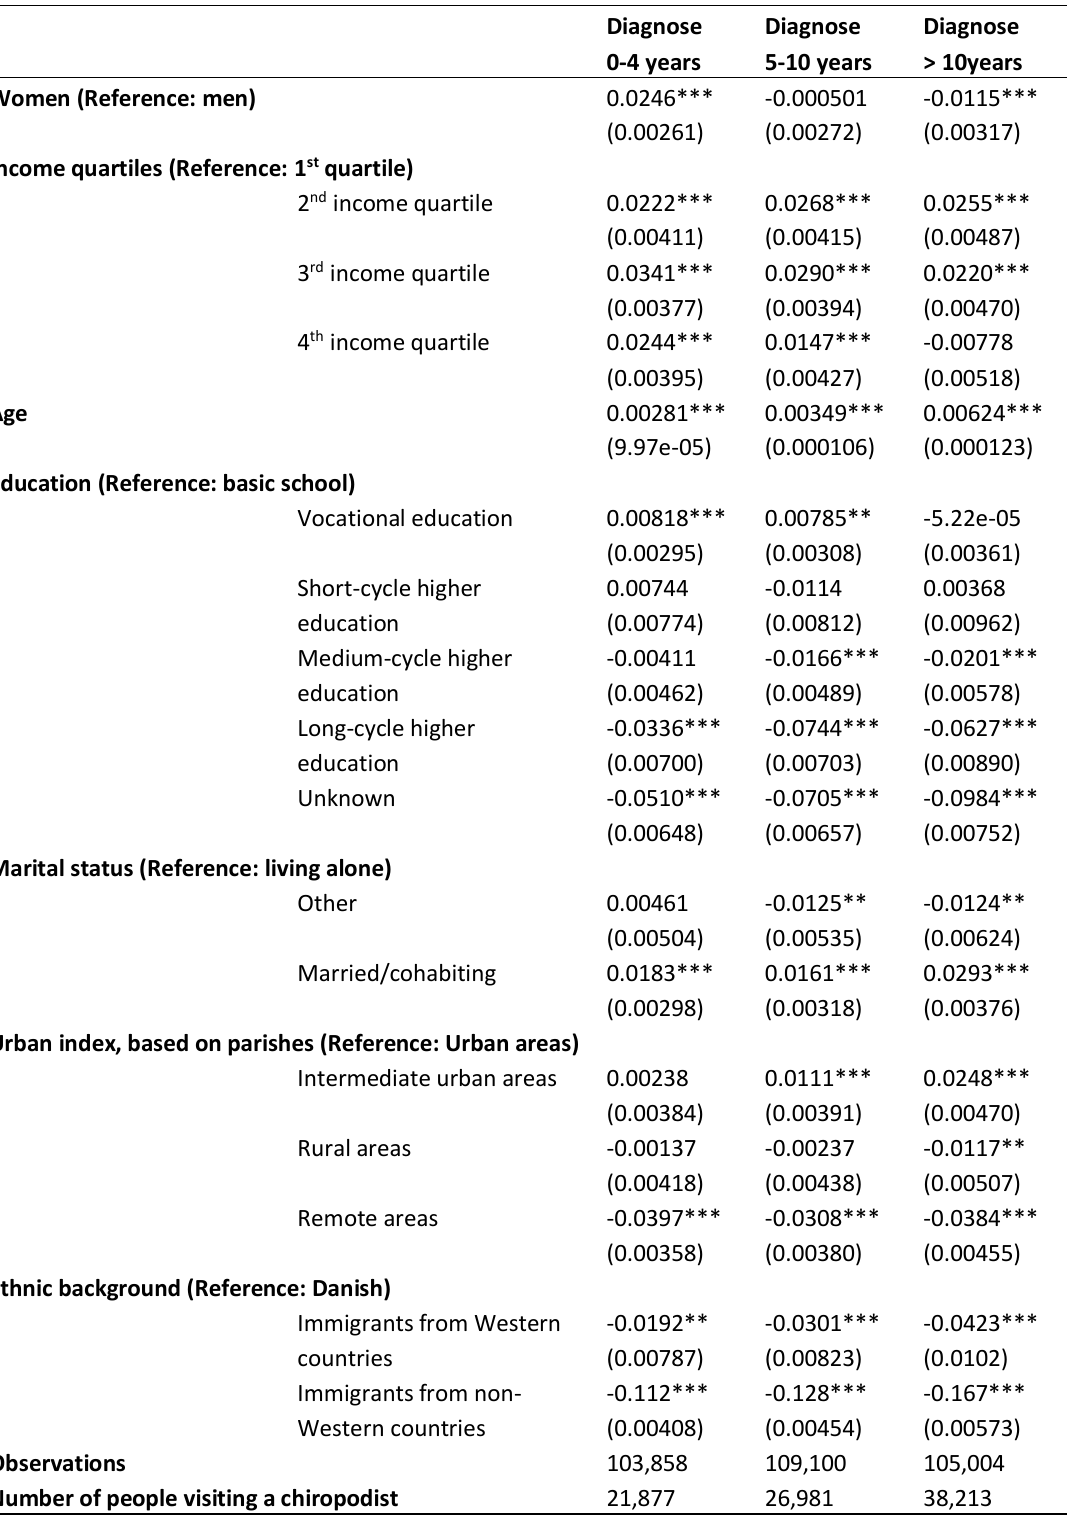
Table 4: Year of diagnosis conditional models, 2012, marginal effects